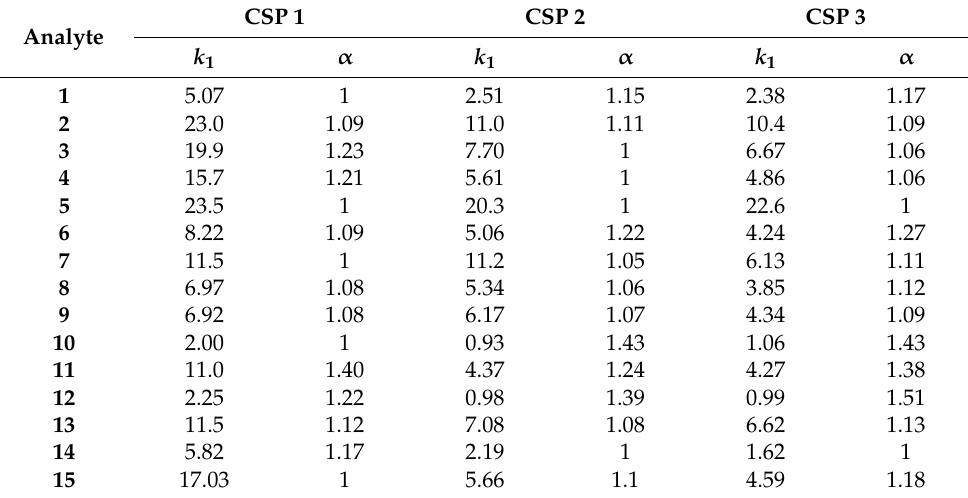
Table 1. Chromatographic data: retention factors of first eluted enantiomer ( k 1 ) and separation factor ( α ) for the chiral DHP analytes on Pirkle-type CSPs in fixed experimental conditions a